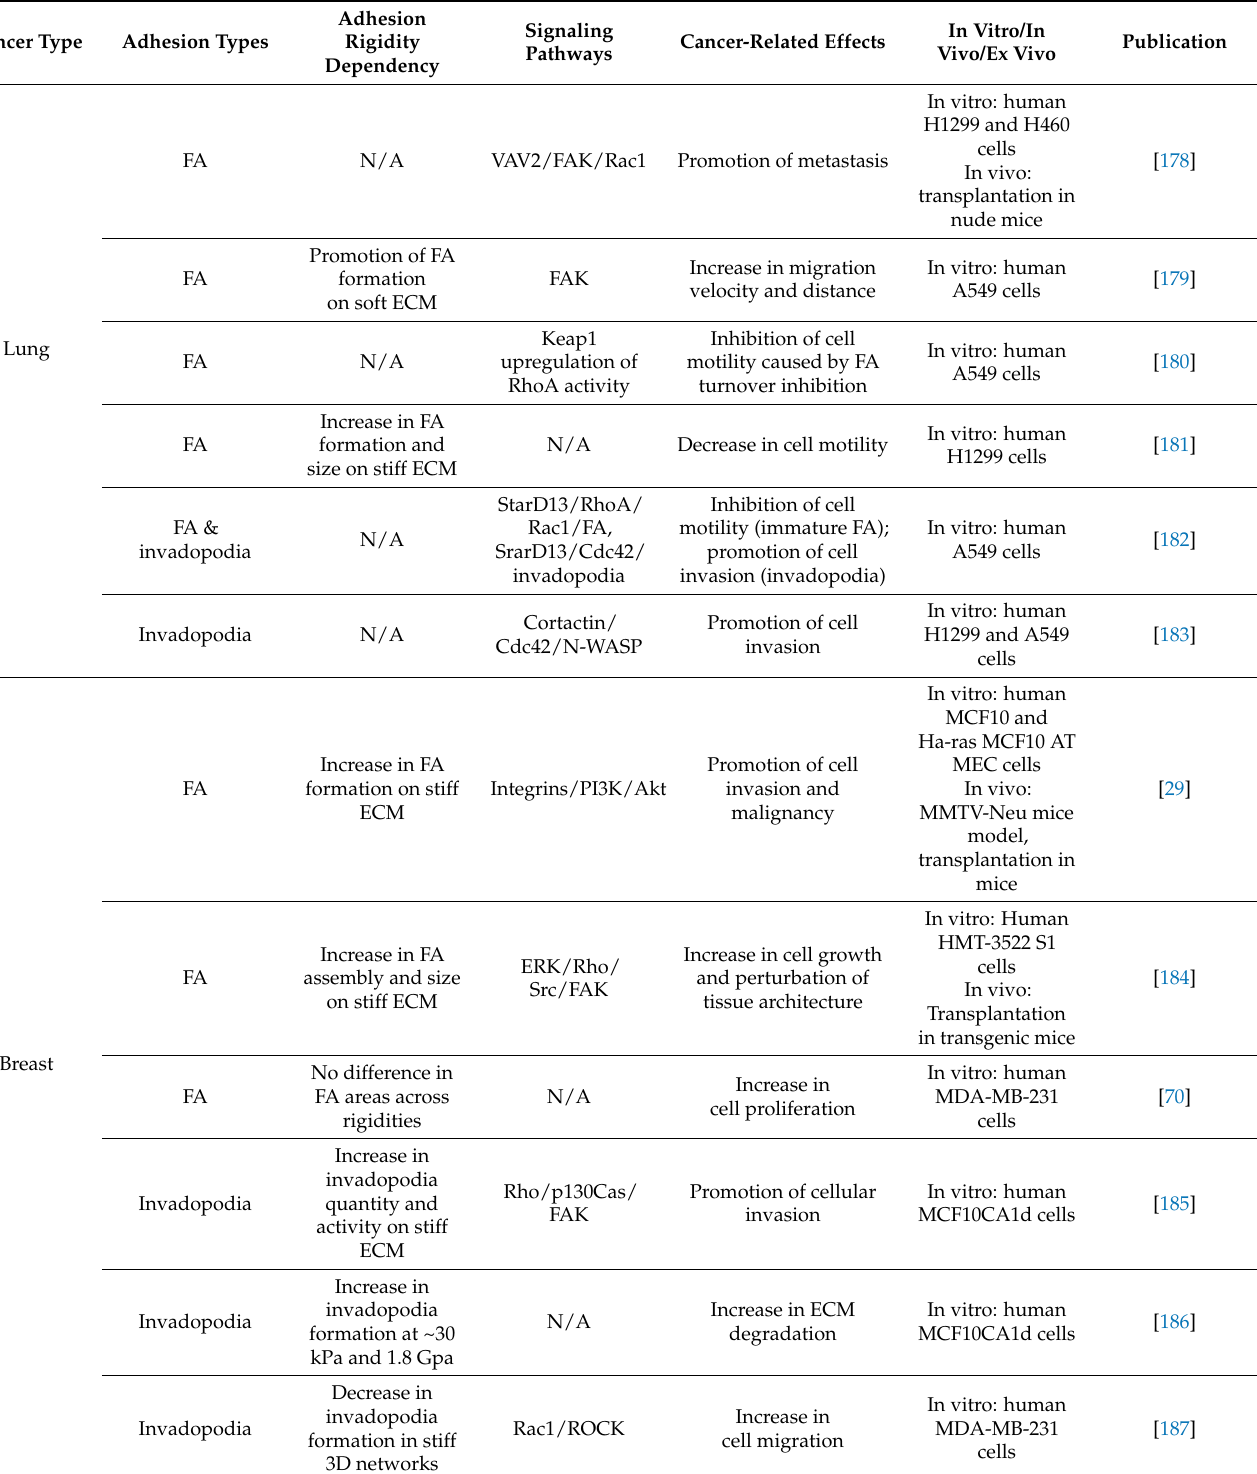
Table 2. Adhesion structures and related signaling pathways in different cancer